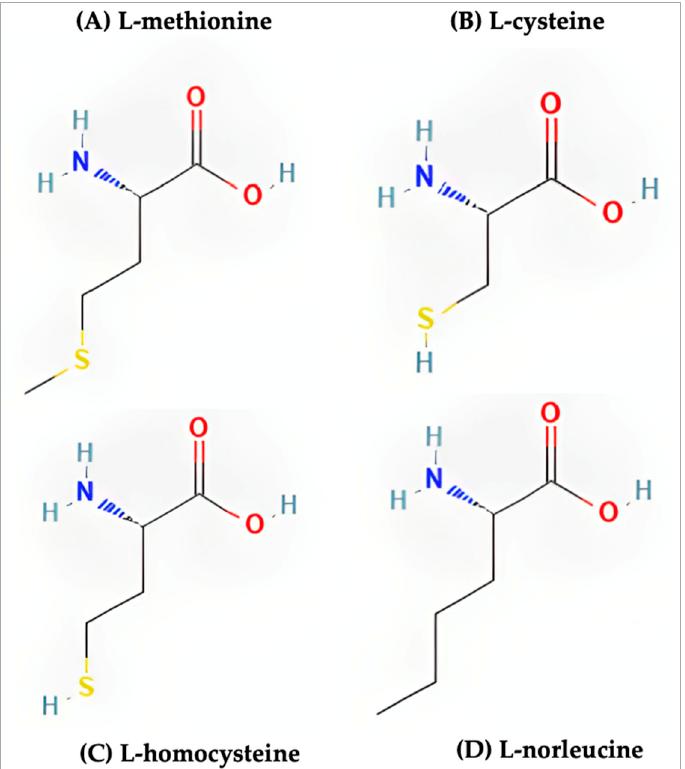
Figure 1. Structure of the sulfur-containing amino acids. ( A ) L -methionine (PubChem CID 6137), ( B ) L -cysteine (PubChem CID 5862), ( C ) L -homocysteine (PubChem CID 91552), ( D ) L -norleucine (PubChem CID 21236).